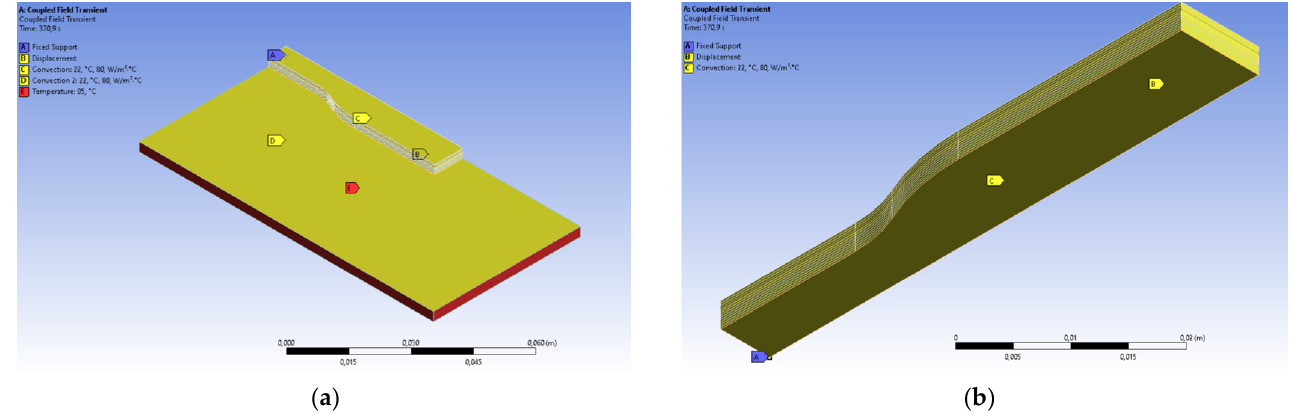
Figure 2. ( a ) Thermal boundary conditions. ( b ) Structural boundary conditions (zero translation along the normal direction and rotation on each node of symmetry surfaces).